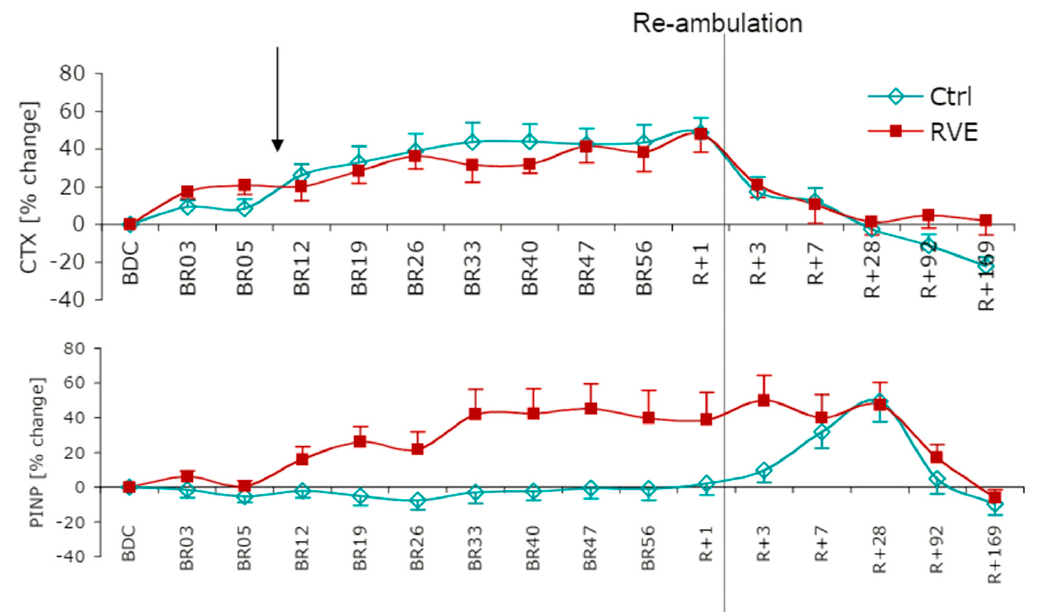
Figure 1. Changes in markers of bone formation and resorption during and after bed rest (8 weeks of strict bed rest; Berlin Bed-Rest Study) in each subject group. Cross-linked C-terminal telopeptide of type I collagen (CTX; bone resorption), procollagen type I amino terminal propeptide (P1NP; bone formation). The error bar represents the standard error of the mean percentage of the difference from baseline (BDC-2) values. Ctrl, control group; RVE, resistive vibration exercise group [8].